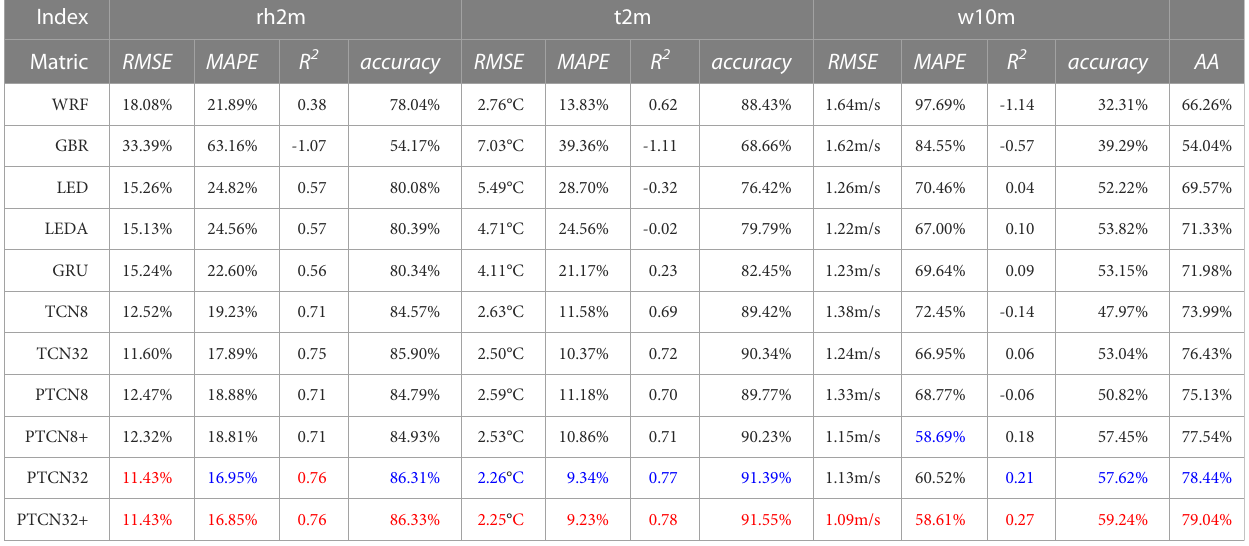
TABLE 3 Comparison of proposed methods with some popular sequence prediction methods on WFD2018 aic